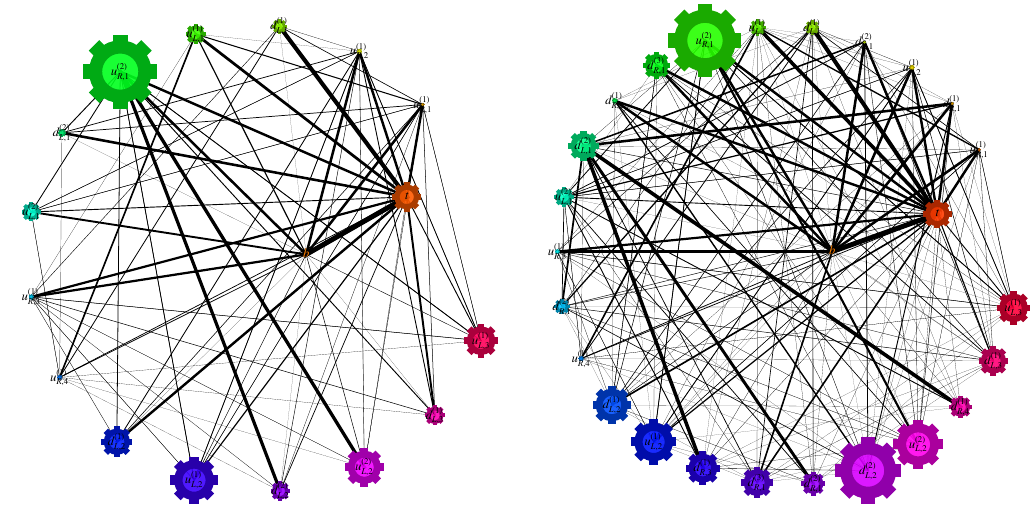
Figure 15 . Spectrum and decay patterns of gears for benchmarks 1 (left plot) and 2 (right plot). The collider accessible gears, along with the SM b and t quarks, are drawn in a mass ordered counter- clockwise spiral, where Q ( i ) = ( u ( i ) ; d ( i ) ) are the mass eigenstates of the vector-like quark SU(2) L L;k L;k L;k doublet chain, and u ( i ) ; d ( i ) for the singlet chains. The distance from the center is logarithmically R;k R;k proportional to particle’s mass, log( M= 1 GeV), while the symbol’s diameter is proportional to / particle’s width, log(1 + (cid:0) = 1GeV). The main decay channels are denoted by black lines, with / the width of the lines proportional to the respective branching ratios (the decays have in addition Z; W , or H in the (cid:12)nal state, not shown above, and for neutral current transition we sum over the (cid:12)nal states with Z and H